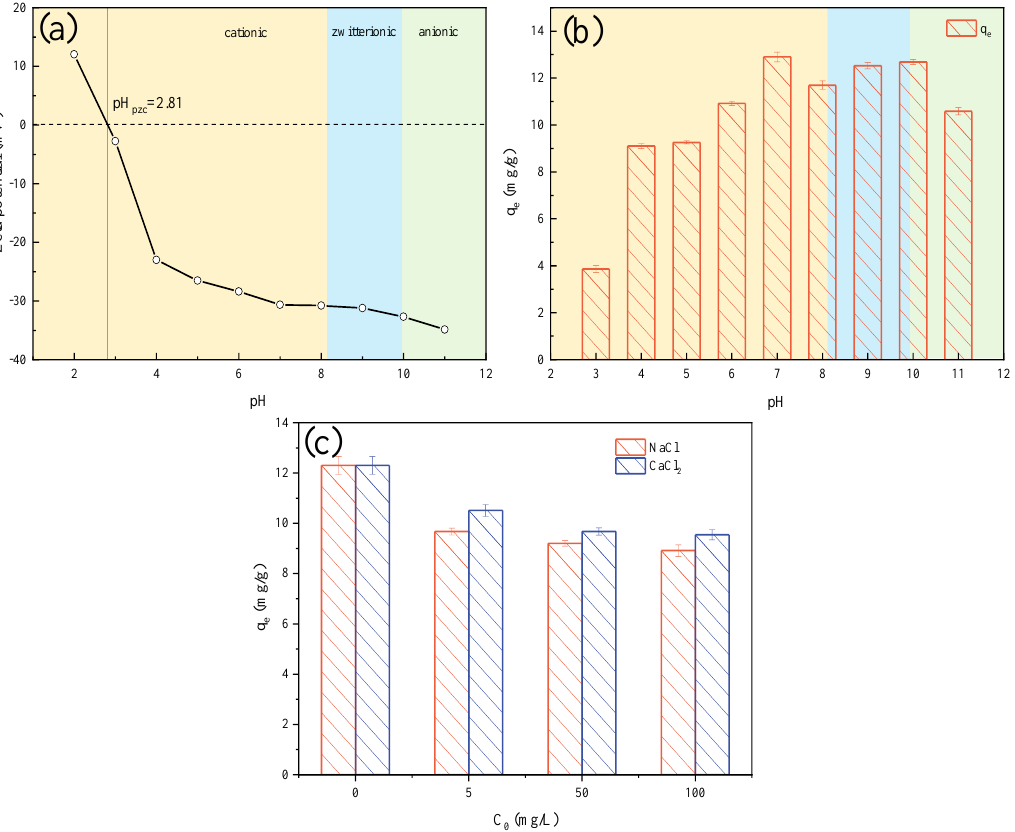
Figure 6. Zeta potential of Fe/Mg-RSB ( a ). Effects of pH ( b ) and ions ( c ) on CQP adsorption by Fe/Mg-RSB.